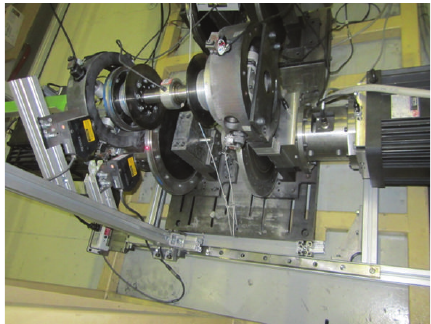
Figure 2: Roller rig with single suspended wheelset.